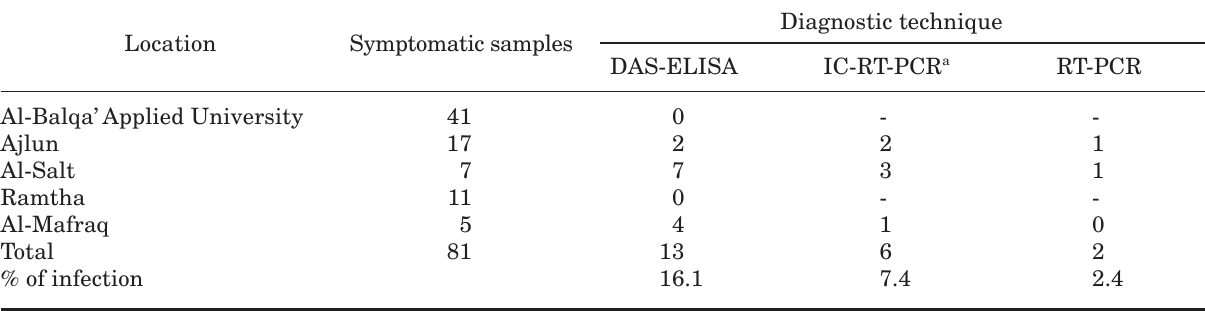
Table 1. Detection of grapevine virus A in symptomatic grapevines samples from different locations in